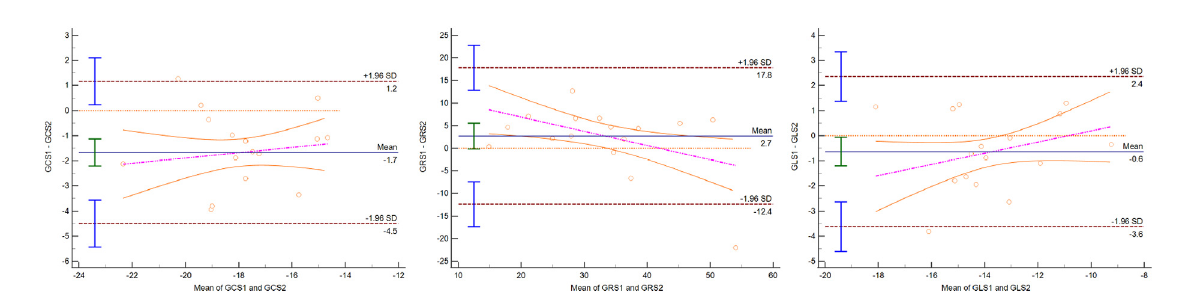
FIGURE4 Bland–Altman plot indicating that 95% or more dots were located in 95% confidence interval for GCS, GRS, and GLS between CC and one BH CSC